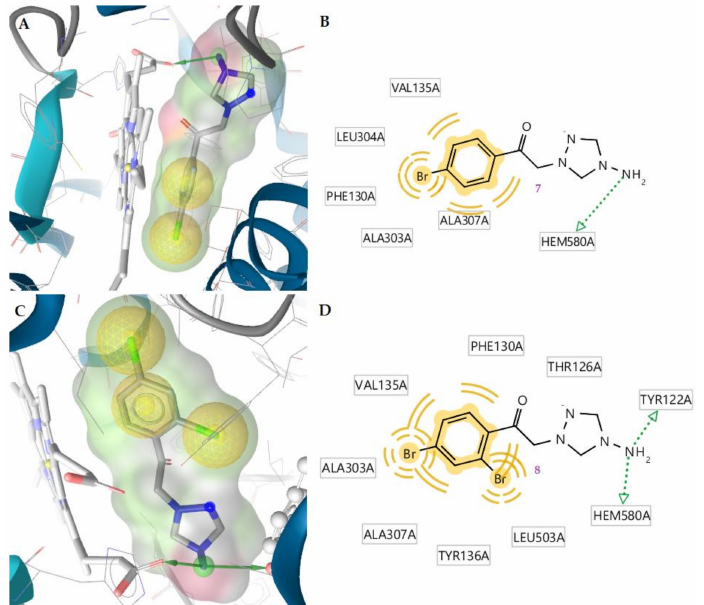
Figure 6. Docking pose of the compound 7 ( A ) and 2D diagram ( B ) in 14-alpha demethylase (CYP51B) from the fungus Aspergillus fumigatus . Docking pose of the compound 8 ( C ) and 2D diagram ( D ) in 14-alpha demethylase (CYP51B) from Aspergillus fumigatus . Green dotted arrows indicate hydrogen bonds, and yellow spheres indicate the hydrophobic interactions.